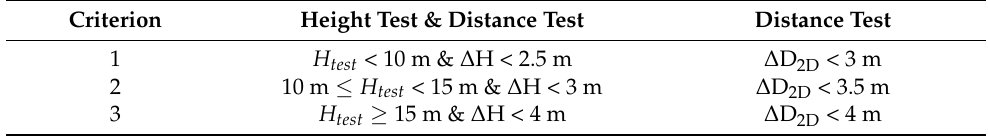
Table 2. Height and neighborhood criteria for the candidate search. H Test , height of test tree; ∆ H, height difference between test (i.e., ALS/ULS tree crown centroid) and reference (i.e., TLS tree crown centroid); ∆ D 2D , 2D distance between test and reference